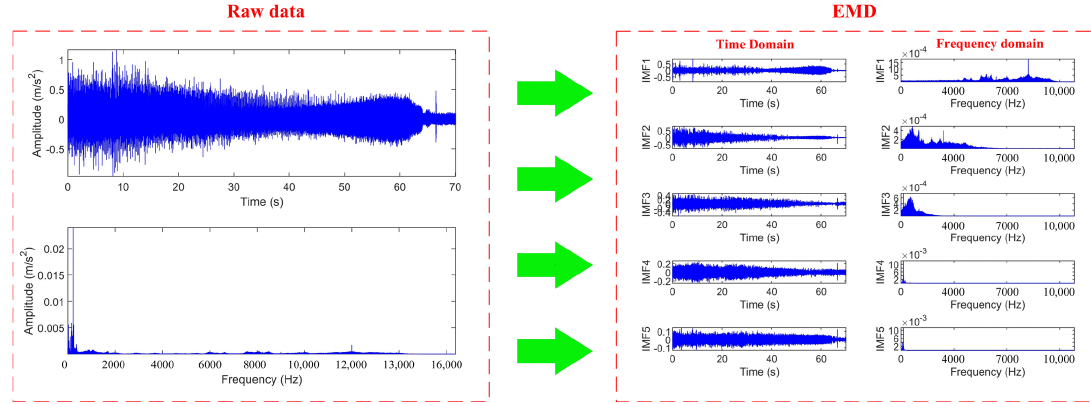
Figure 2. Empirical modal decomposition (EMD) process of the original vibration signal.